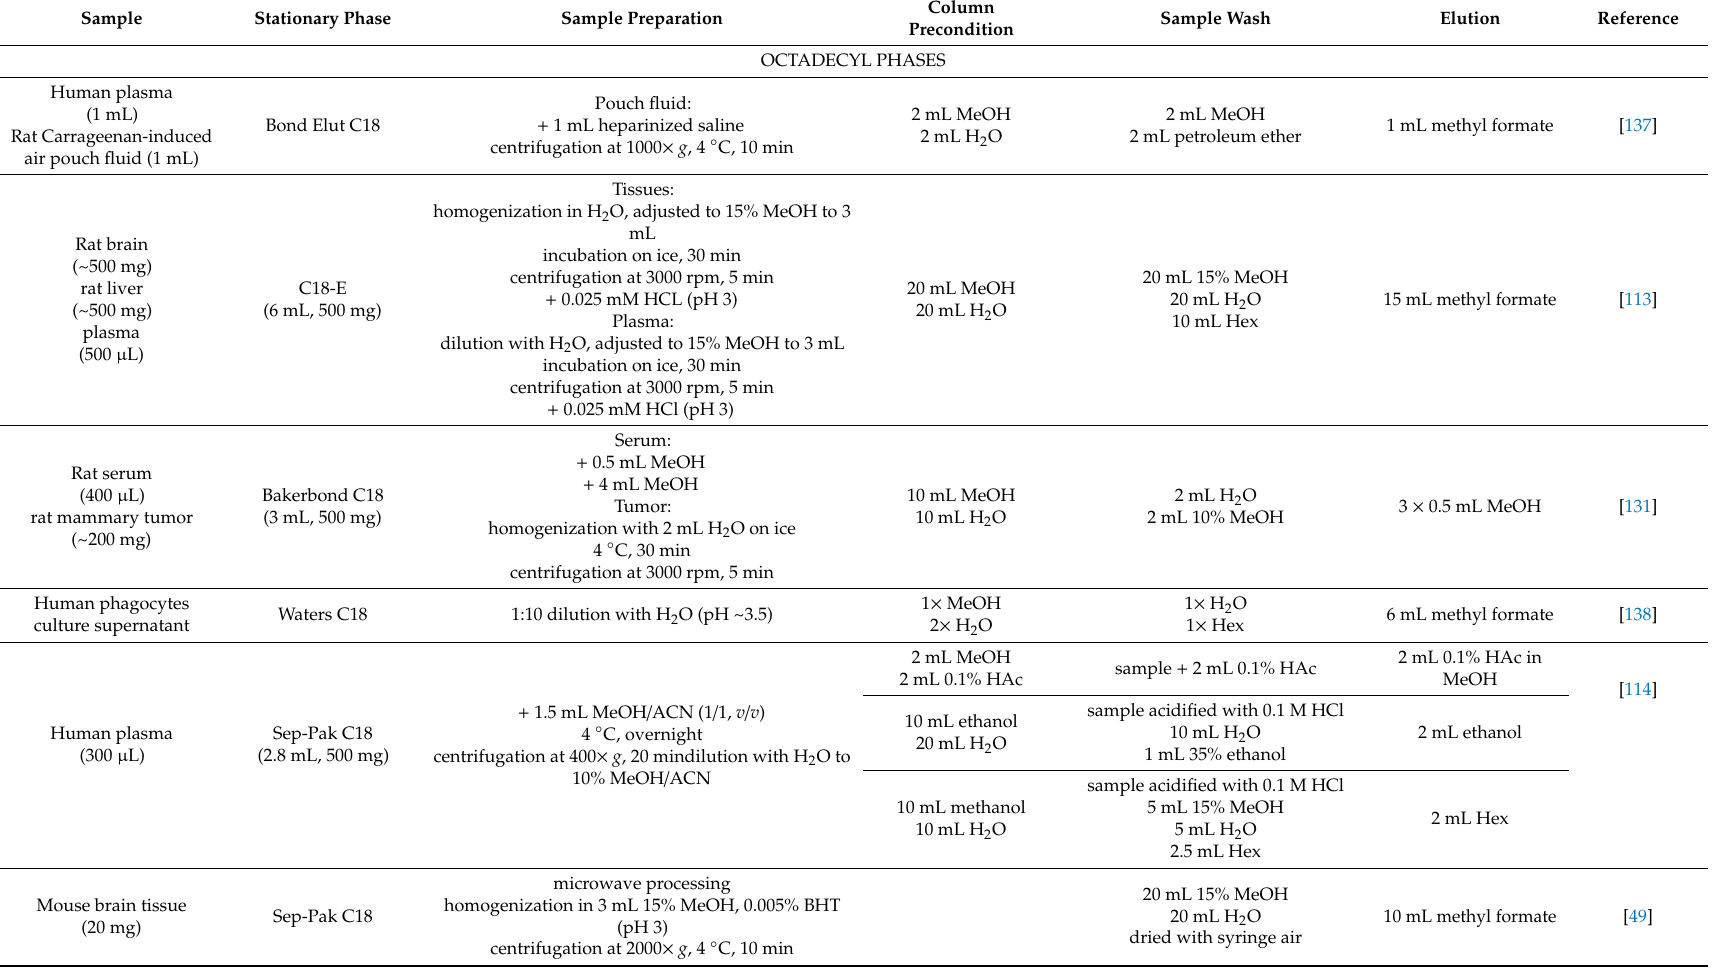
Table 2. Representative SPE cartridges and extraction conditions for purification of selected